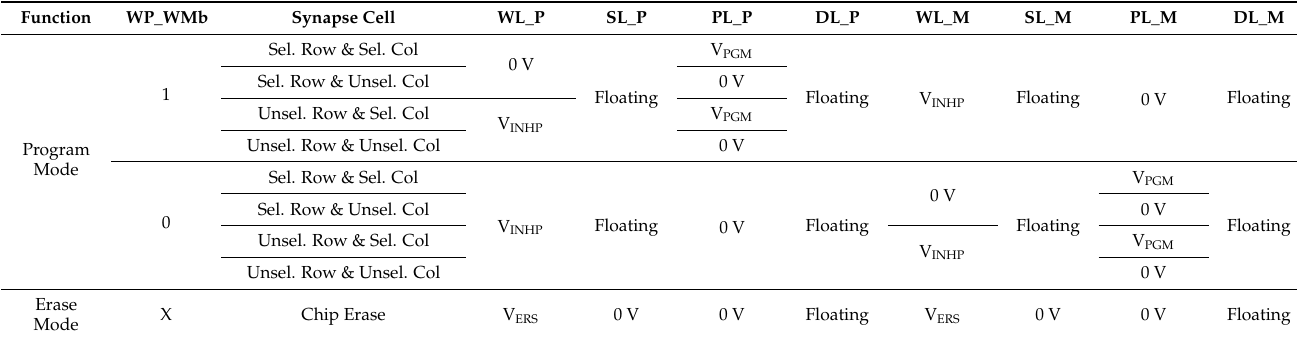
Figure 3. Synaptic cell based on TFT eFlash cell with programmable weights +1, − 1, and 0. Table 3. Bias conditions of TFT eFlash cell for each operation mode.